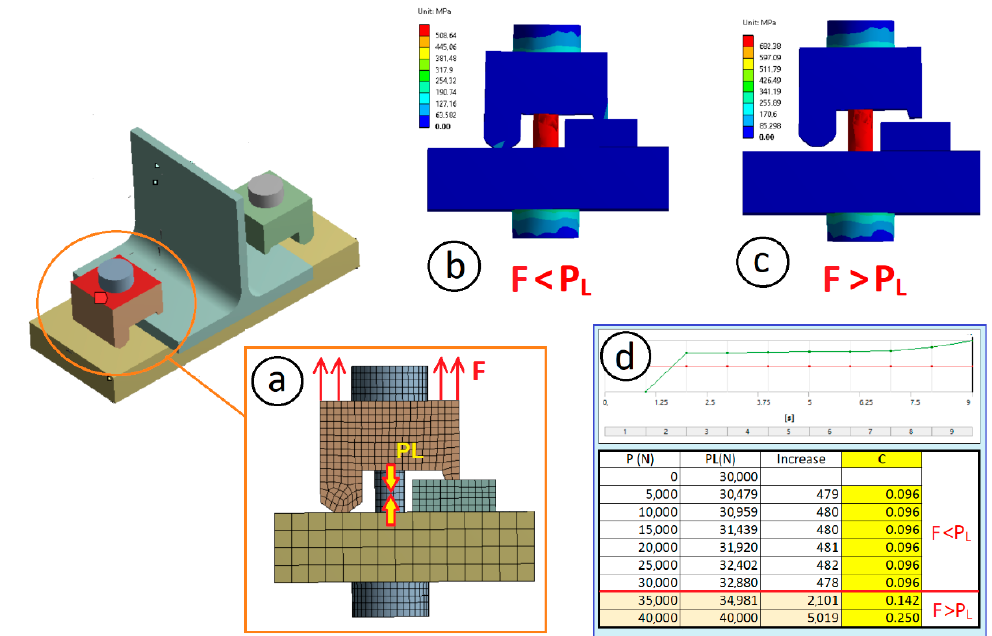
Figure 8. Calculation by simulation of the coefficient C of stiffness of the joint: ( a ) applied forces and meshing of the model; ( b ) stresses and deformation when the applied load F is less than the preload of the bolt; ( c ) stresses and deformation when the applied load F is greater than the preload of the bolt; ( d ) results obtained with the simulation and obtaining the ( C ) stiffness coefficient.